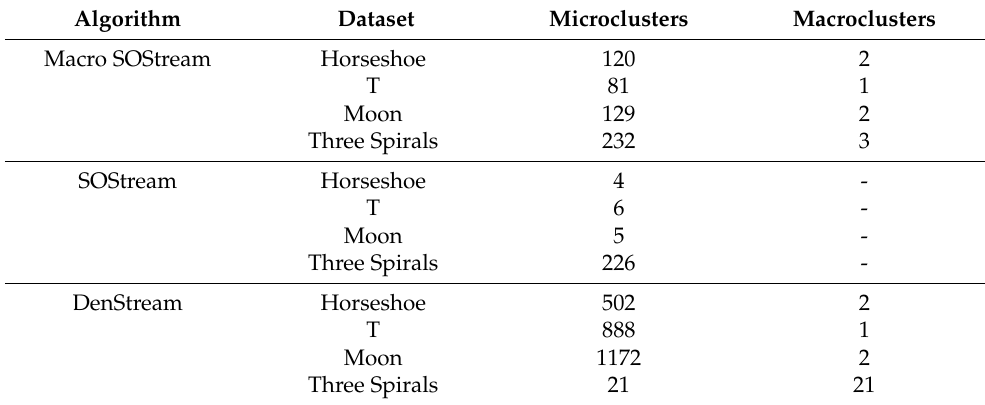
Table 4. The number of clusters found by evolving algorithms.